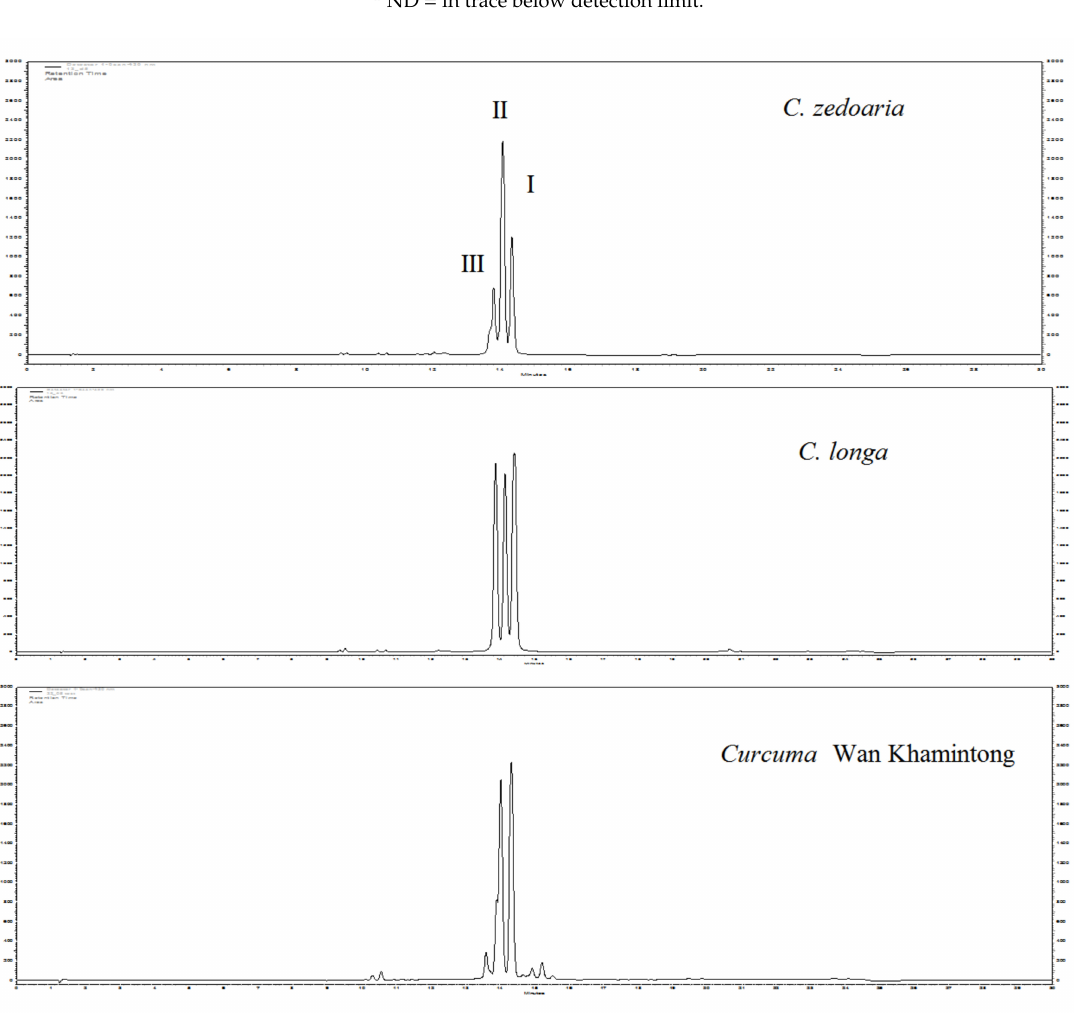
Figure 3. HPLC chromatogram (420 nm) for C. zedoaria , C. longa , and Curcuma Wan Khamintong; I: curcumin ( 1 ), II: demethoxycurcumin ( 2 ), III: bisdemethoxycurcumin ( 3